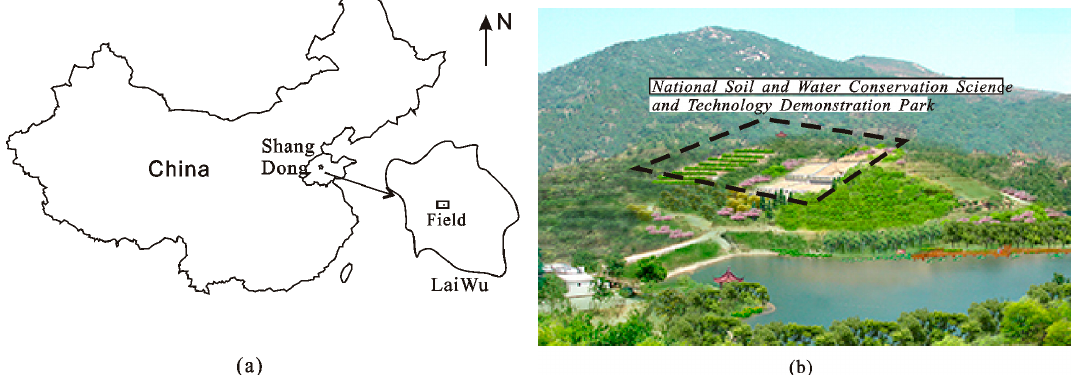
Figure 1. A diagram of the experimental plot location (( a ) map of the traffic in the experimental plot; ( b ) photo of the experimental plot).